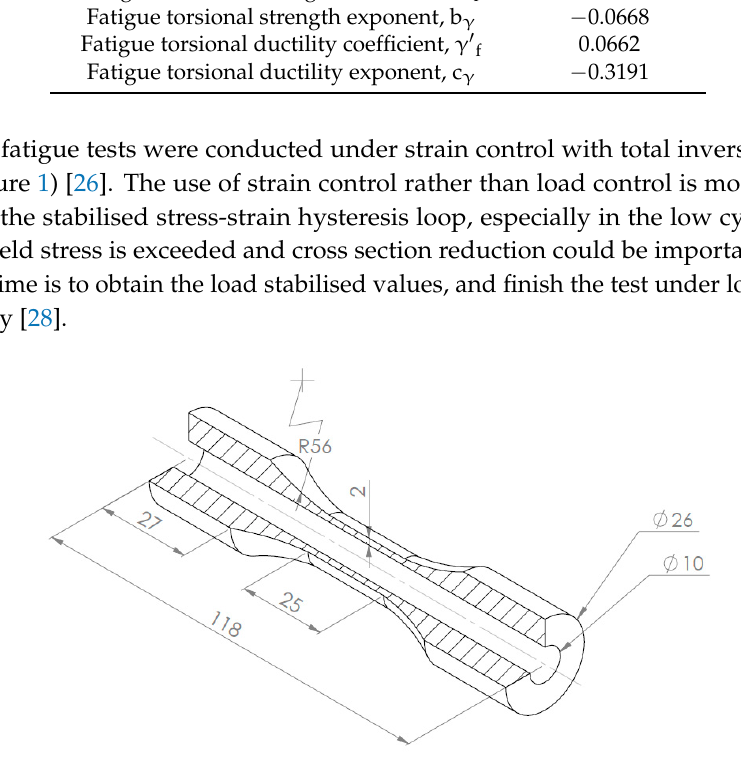
Figure 1. Geometry of the specimen. All dimensions are in mm.